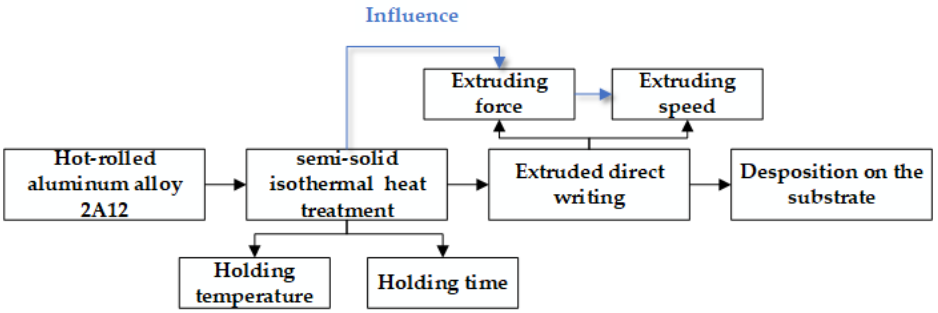
Figure 1. Scheme of the semi-solid direct-writing formation process. Table 1. Typical chemical components of 2A12 aluminum alloy.